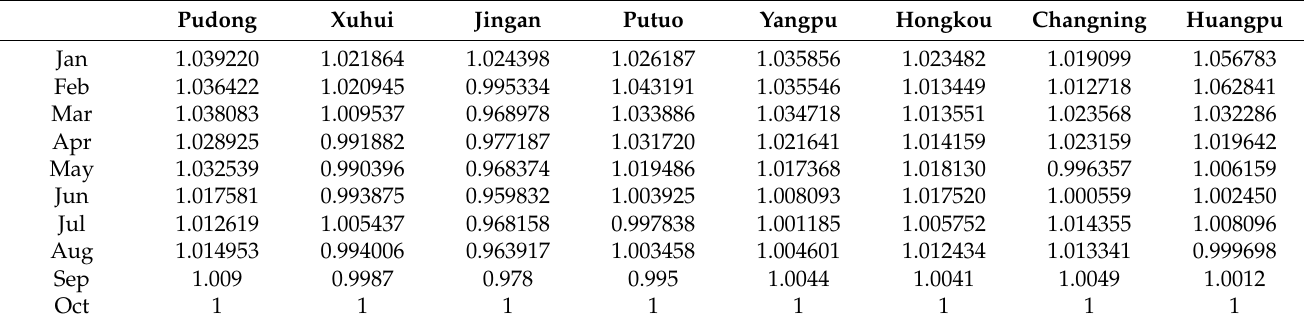
Table A2. The price adjusting index according to the transaction